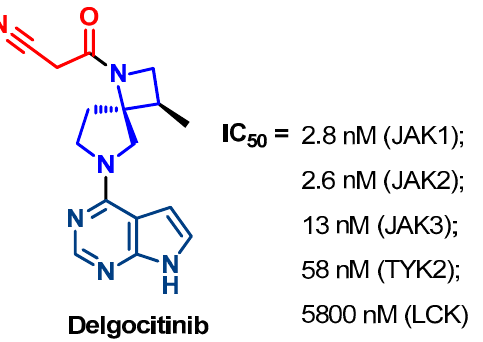
Figure 23. Kinase inhibitor activity of delgocitinib.